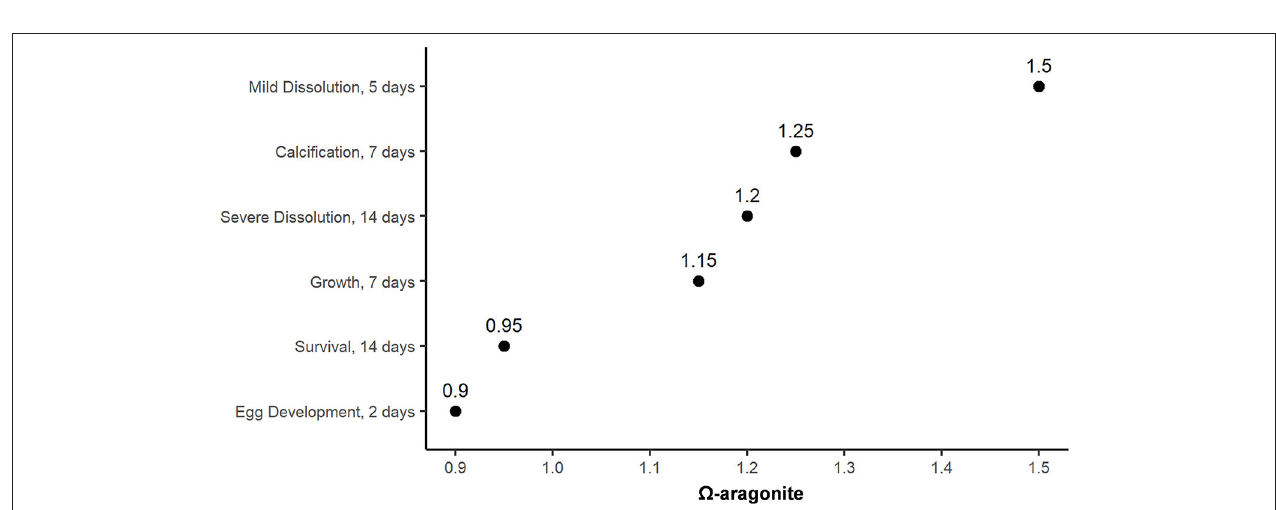
FIGURE 6 | Synthesis of thresholds related to six different endpoints, characterized by its magnitude ( (cid:127) ar ), and duration of exposure response. The thresholds were determined based on experimental and field data using breakpoint analyses and expert consensus.